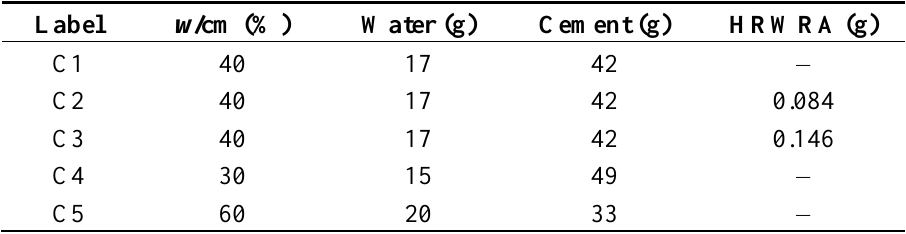
Table 2. Mix proportions of prepared